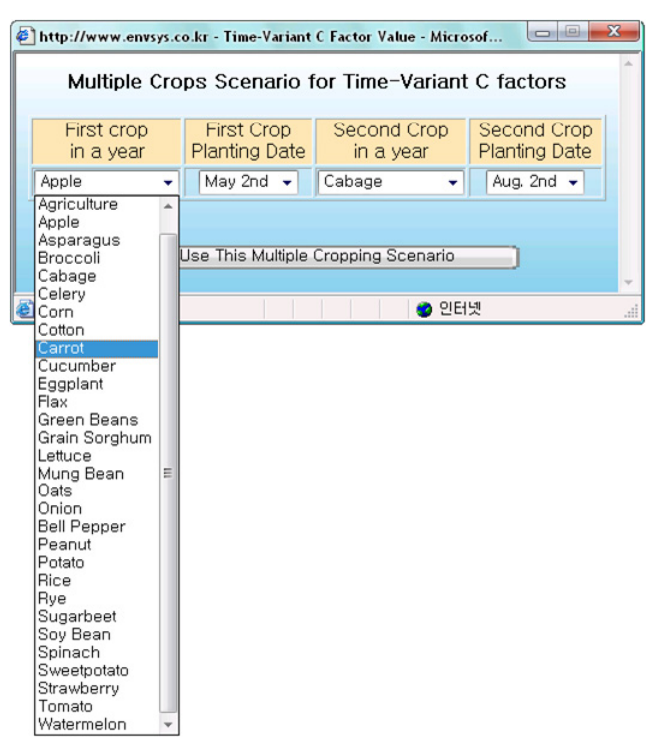
Figure 8. Time-Variant USLE C factor DB of 30 major